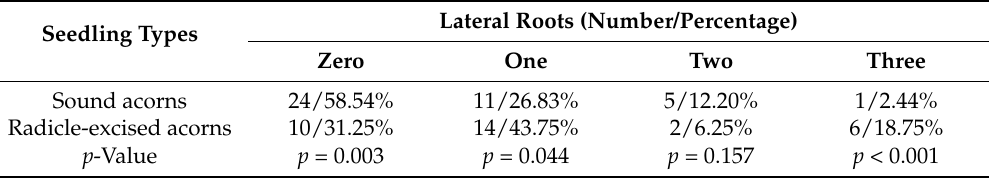
Table 1. Comparison on lateral roots of seedlings derived from sound and radicle-excised acorns. Seedling